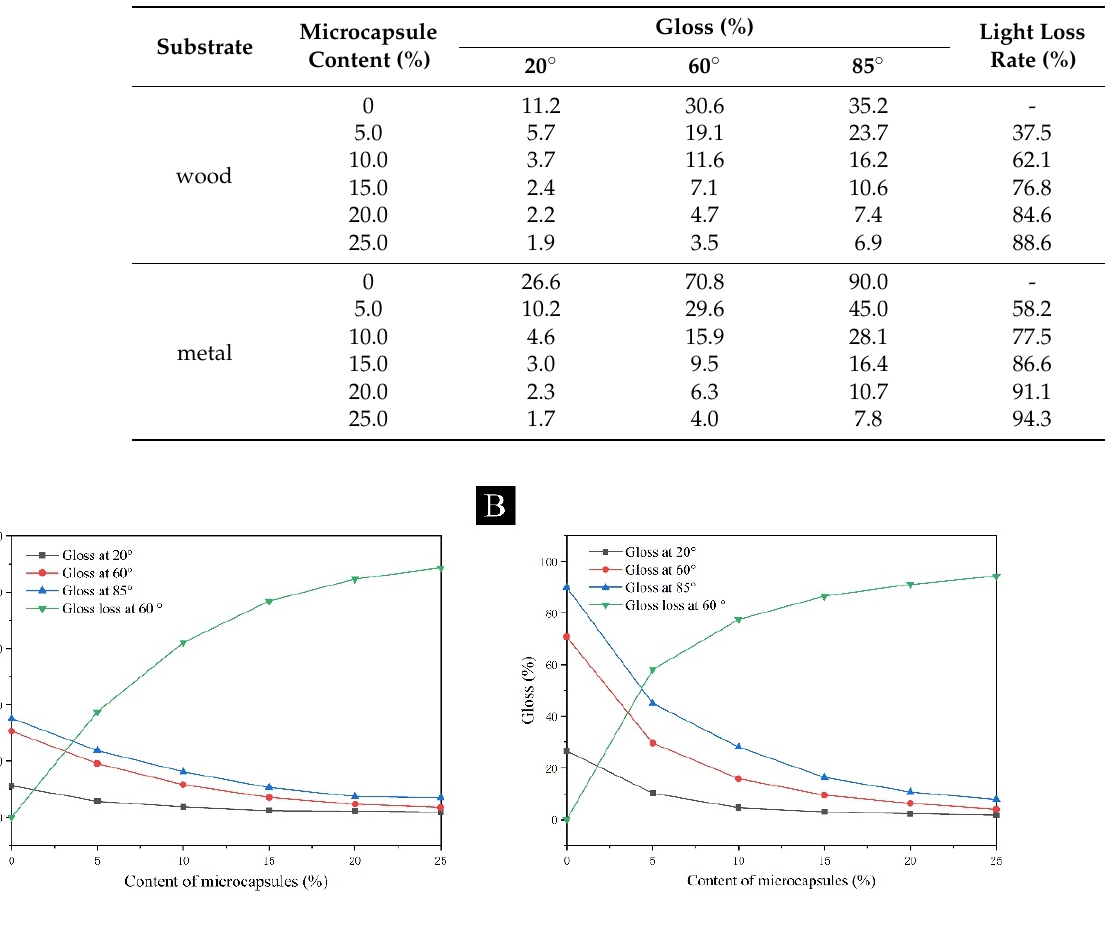
Figure 13. Gloss of coatings with different microcapsule contents: ( A ) on wood substrate, ( B ) on metal substrate.